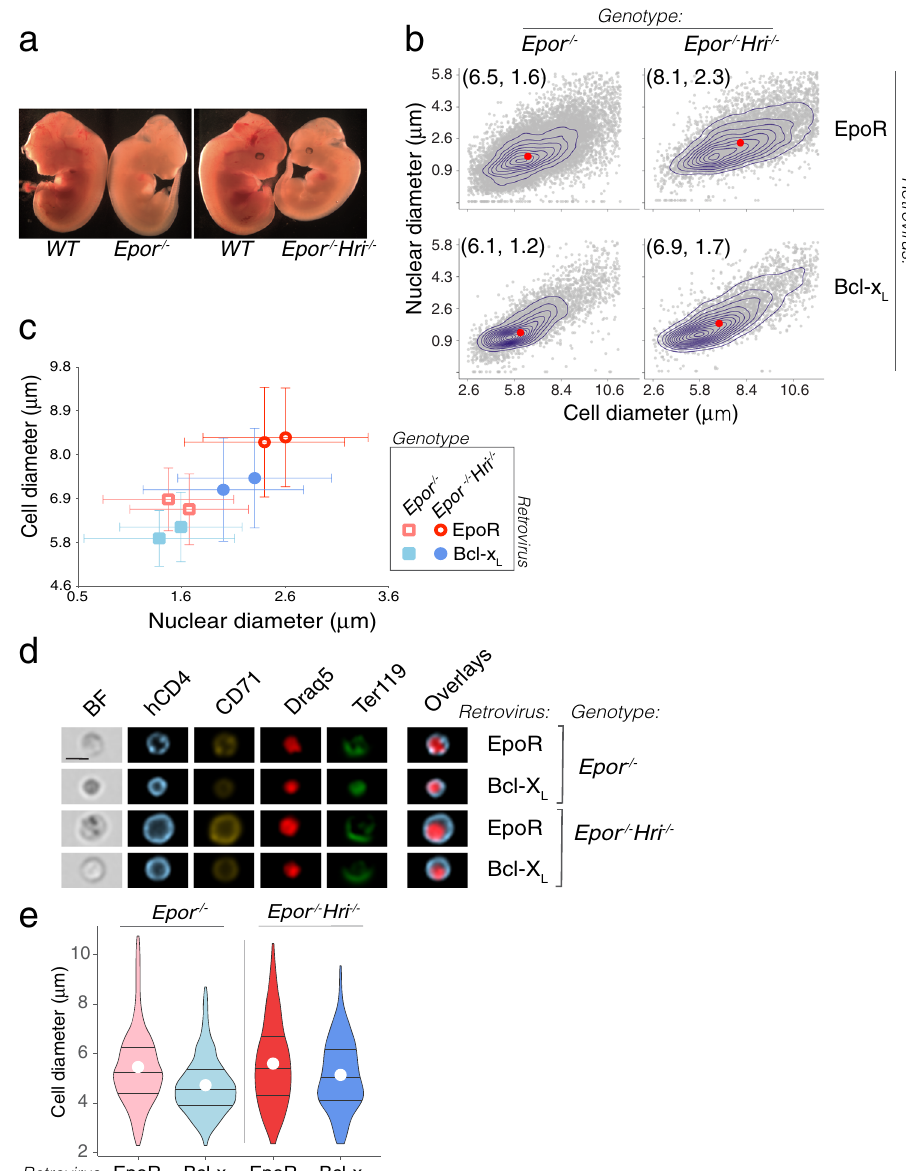
Fig. 5 EpoR regulates cell size independently of HRI. a Epor − / − and doubly deleted Epor − / − Hri − / − E12.5 embryos with wild-type littermates. b Cell and nuclear diameters in fetal livers from either Epor − / − or Epor − / − Hri − / − embryos, transduced with either EpoR or Bcl-x L , at t = 48 h post transduction. Individual sample contour plots are overlaid on scatter plots (each dot is one cell). Red dots indicate distributions ’ medians. c Summary data for cell and nuclear area, for two independent experiments as in ( b ), each containing all 4 genotype/retrovirus combinations. Data are mean ± SD for each cell population. Each transduced population consisted of pooled fetal liver cells from either Epor − / − or Epor − / − Hri − / − embryos. Cell diameter data for all genotypes is signi fi cantly different ( p = 0.0008, one-way ANOVA between population means); On the Hri − / − Epor − / − background, cell diameter is signi fi cantly different between Bcl-x L and EpoR-transduced cells ( p = 0.019, one-way ANOVA from two independent experiments). d Imaging fl ow cytometry of representative Lin − hCD4 + Ter119 + erythroblasts from each of the genotype/retroviral combinations at t = 48 h. Representative of at least 3 independent experiments. Scale bar = 10 µ m. e Epor − / − and Epor − / − Hri − / − reticulocyte cell diameter, from cultures transduced with either EpoR or Bcl-x L . Representative of 2 experiments. Violin lines mark the 25th, 50th, and 75th percentile with a white circle marking the